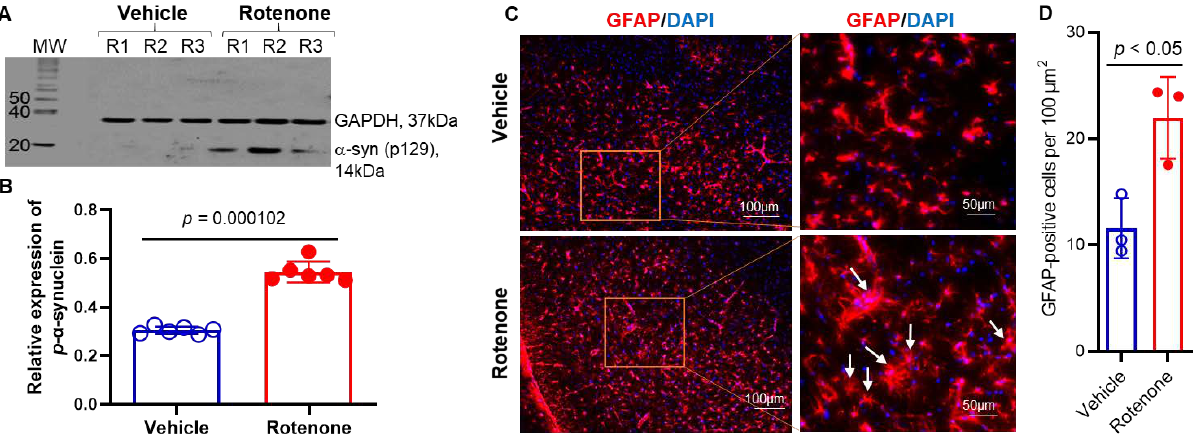
Figure 1. Administration of rotenone-induced increased expression of p- α syn 129 in the dorsal striatum of Lewis rats. ( A ) A representative photomicrograph of Western blot analysis showed increased expression of p- α -syn 129 in the striatum. GAPDH was used as a loading control. MW = molecular weight in kDa. ( B ) Densitometric analysis of p- α -syn 129 protein expression by ImageJ software shows that there is a significant increase ( p < 0.001) in the synuclein protein expression in rotenone rats. N = 6. ( C ) Presence of highly active GFAP (red)-immunostained astrocytes in the SN following rotenone administration in rats. DAPI (blue) was used for nuclear staining. Representative microphotographs from control and rotenone groups suggest GFAP-immunostained astrocytes are hypertrophied in appearance in rotenone-injected rats as compared to vehicle controls. ( D ) Quantitative analysis of GFAP+ cells by cellSens Imaging Software suggests that astrocyte numbers were significantly increased following rotenone injection. N = 3.